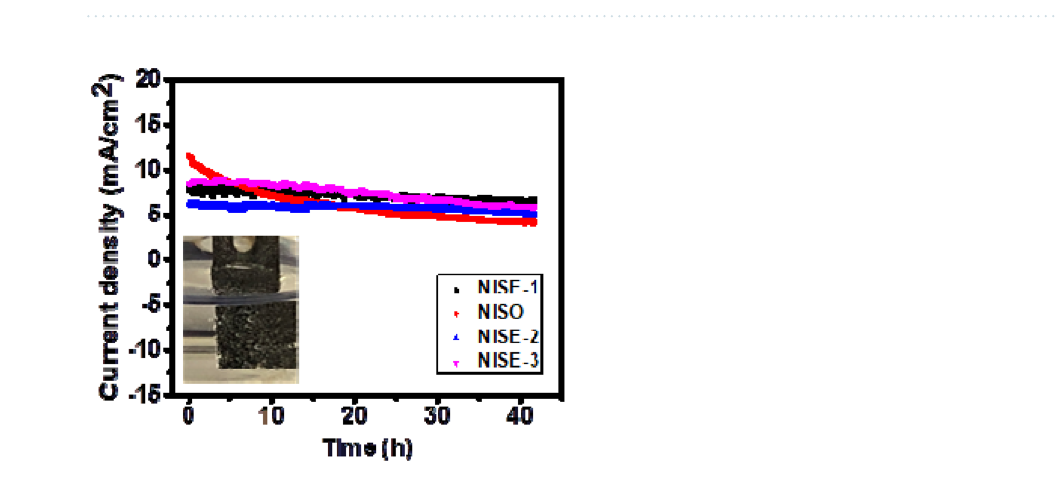
Figure 11. Polarization curves for ( a ) OER, ( b ) HER, and Tafel slopes for ( c ) OER, ( d ) HER.